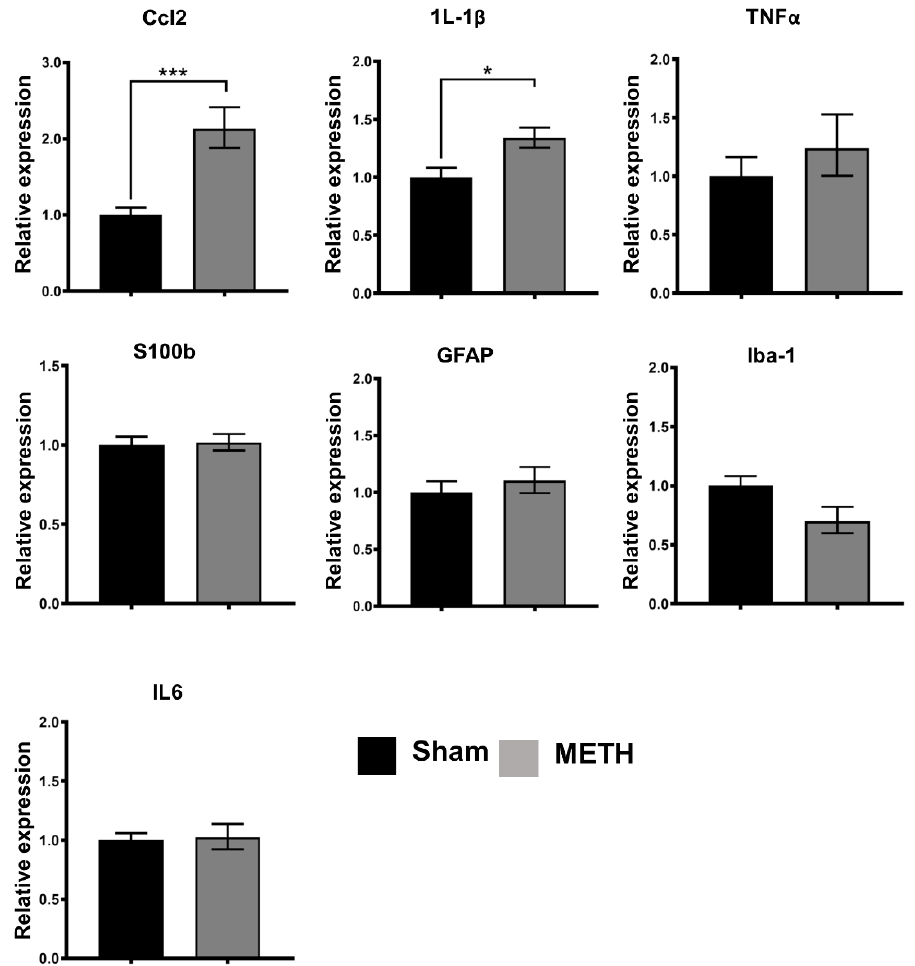
Figure 7. Pro-inflammatory, chemokine, and glial cell markers expression in the hippocampus. Ex- pression of pro-inflammatory cytokines (IL-1 β , TNF α , and IL-6), chemokines (Cxcl1, Ccl2, and Cxcl5), and glial cell markers (GFAP, Iba-1, and S100b) determined by real-time polymerase chain reaction (RT-PCR) in the hippocampus of sham- and METH-treated mice. Values are folding increase ± standard error of the mean (SEM) with respect to the mean of controls, *** p < 0.005, * p < 0.05.